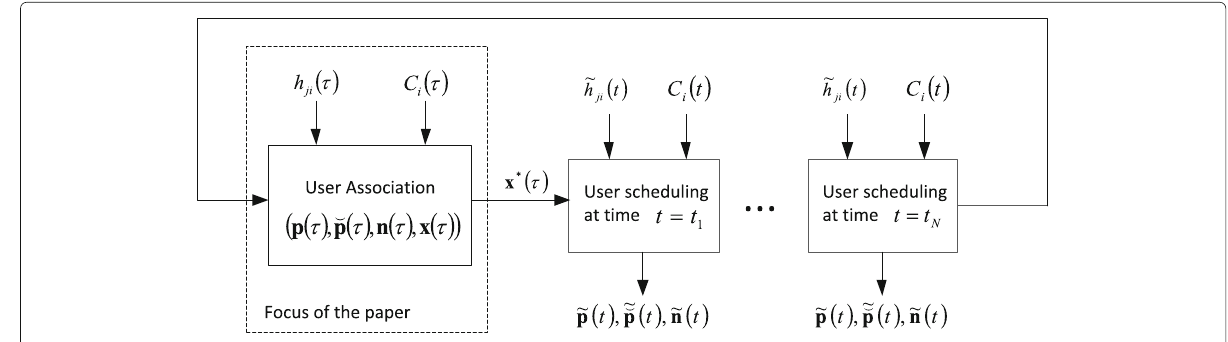
Fig. 1 Schematic description of the user association and the user scheduling